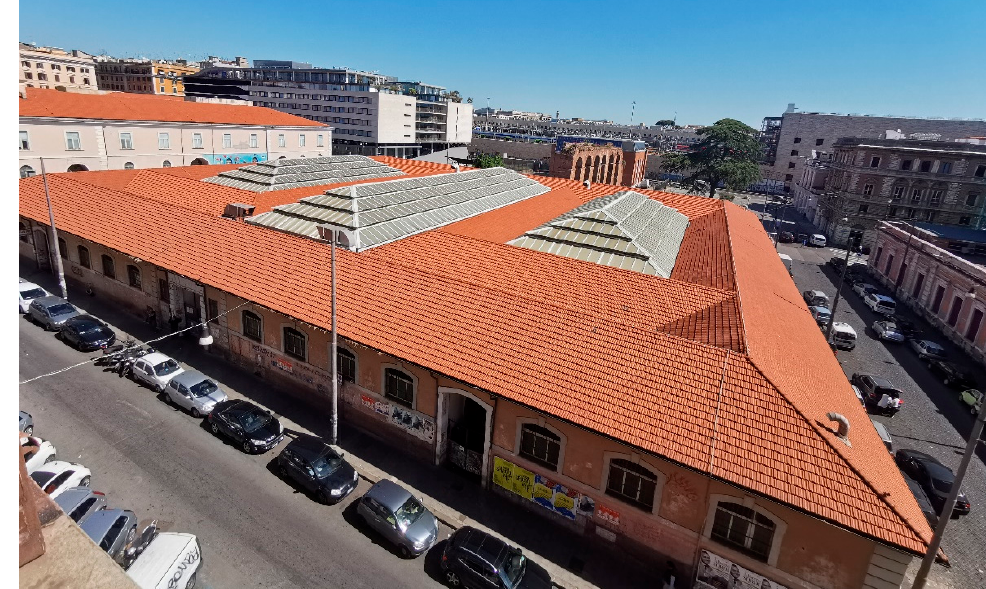
Figure 2. Nuovo Mercato Esquilino from the outside. Photo by S. Mendonce.